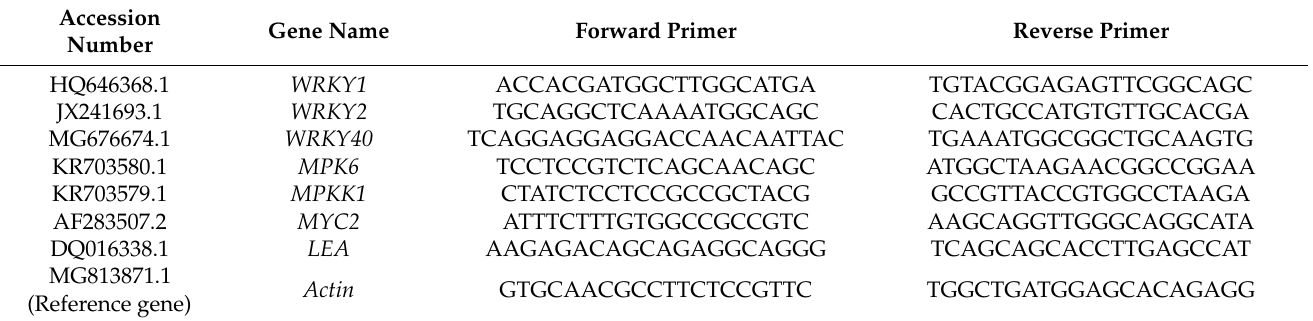
Table 1. Gene IDs and primer sequences for the selected genes used for qRT-PCR.